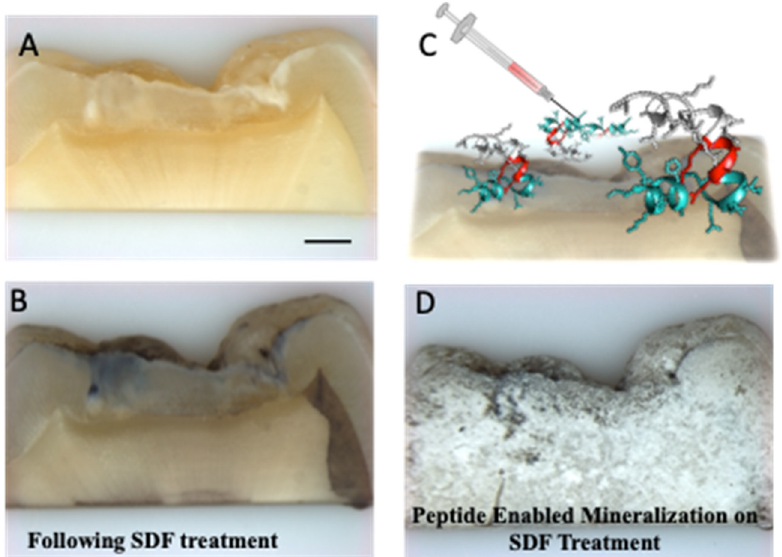
Figure 5. Mineralization by the shADP5-AgBP functionalized SDF-treated dental tissue. Optical microscopy images of untreated dental tissue ( A ) and SDF-treated dental tissue ( B ). A schematic of the bifunctional peptide applied to SDF-treated dental tissue ( C ) follows the colors assigned to the carbon backbone of the peptide shown in Figure 3. Mineralization enabled by the bifunctional peptide functionalized SDF treated dental tissue ( D ). Scale bar, 1000 μ m.